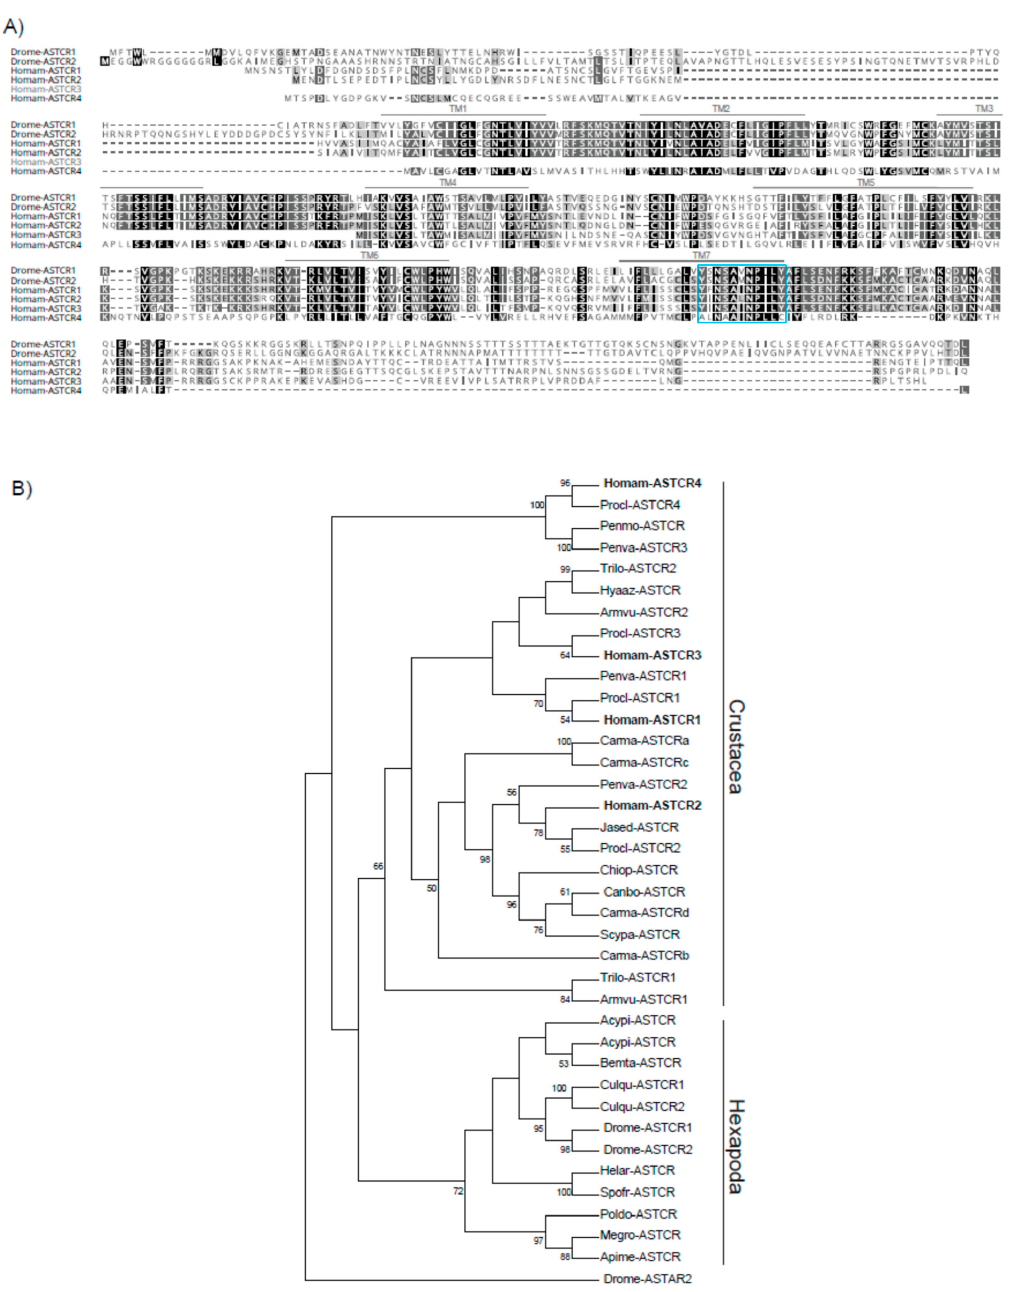
Figure 1. Sequence and phylogenetic analyses suggest ASTCR4 belongs to a more evolutionarily distant group of conserved receptors. ( A ) MUSCLE-based multiple sequence alignment of H. americanus ASTCRs and functionally characterized Drosophila melanogaster AST-C receptors (AAF49259.2 and AAN11677.2). The locations of predicted transmembrane (TM) domains, indicated by a gray overline, are based on the D. melanogaster ASTCR1 sequence. The TM7 motif characteristic of somatostatin/AST-C-type receptors is indicted by a blue box. ( B ) Maximum likelihood tree of ASTCR-like proteins from diverse arthropod species. H. americanus ASTCRs are indicated in bold. The bootstrap consensus tree was inferred from 1000 replicates; shown next to the branches is the percentage of replicate trees in which the associated taxa clustered. Branches corresponding to partitions reproduced in less than 50% of bootstrap replicates have been collapsed. Species abbreviations and accession numbers are listed in Table